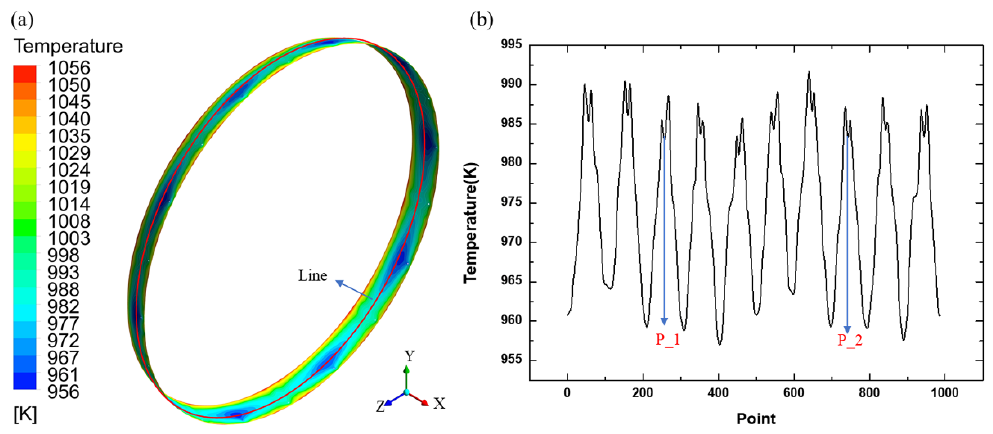
Figure 8. ( a ) Temperature contour of wall_1; ( b ) Temperature distribution of Line.